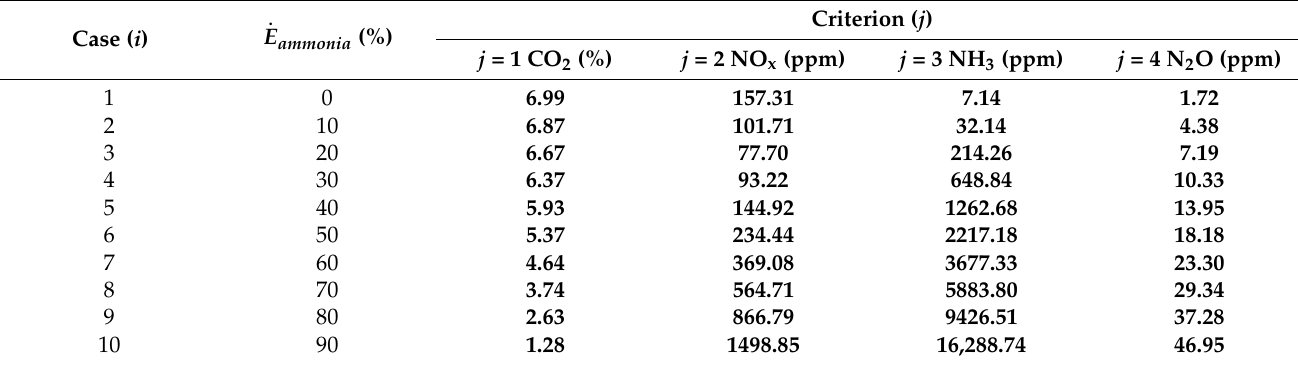
Table 2. Decision